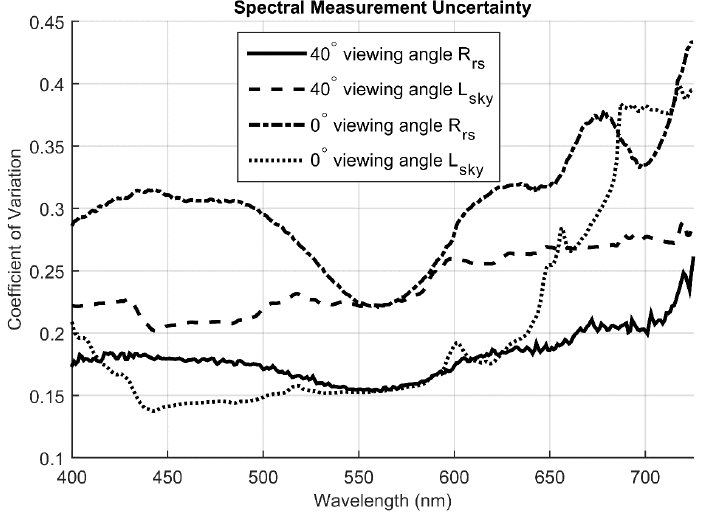
Figure 12. Measurement uncertainty present in all field R rs and L sky measurements. The coefficient of variation was calculated among triplicate replicate measurements and averaged over all sample points.